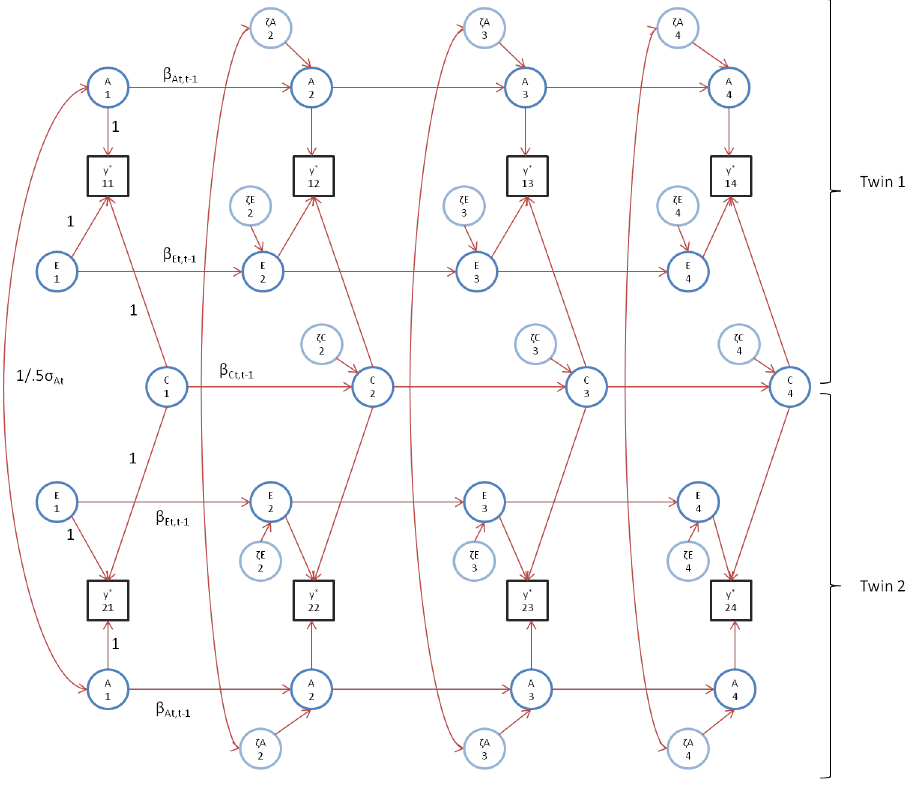
Figure 1. The standard additive genetic, common (shared) and unshared environment (ACE) simplex model depicted for both twins, where y*’s represent the series of observed phenotypes, A’s represent the underlying additive genetic series, C’s represent the underlying shared environment series, and E’s represent the underlying unique environment series. Within each series, ζ represents innovation and β represents stability. Conform biometric theory, the covariance between the A’s at each time point is set equal to ) (for MZ) or 0.5 var(A ) (for DZ twins). For clarity reasons, time specific effects the var(A t t ( i.e. , a, c, and e) and phenotypic means are omitted. Note that the scaling and parameter labels are used throughout the